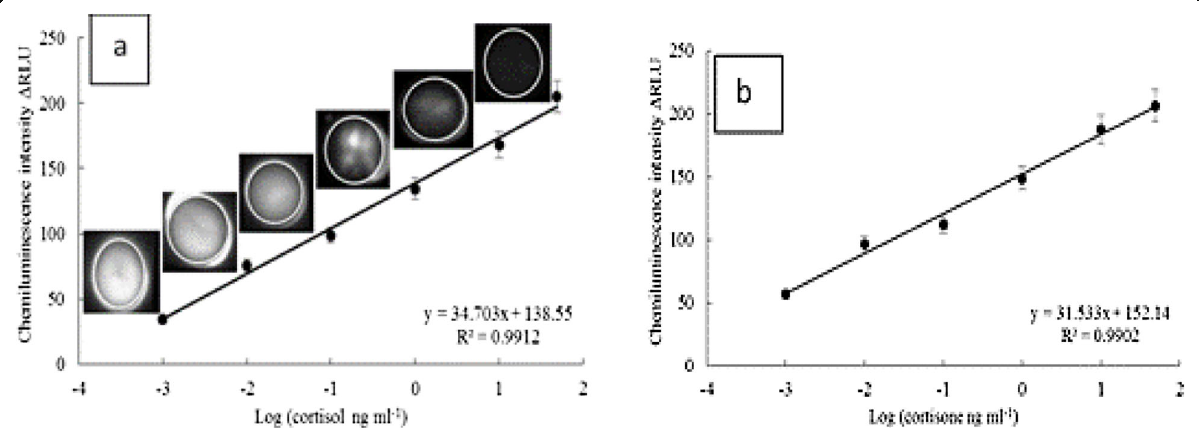
Fig. 9 Calibration curve of a cortisol and b cortisone standard solutions with concentrations from 0 to 50 ng ml − 1 . Standards plotted against the Δ RLU (relative light unit) emission response, insert in the figure a CL image of each standard cortisol